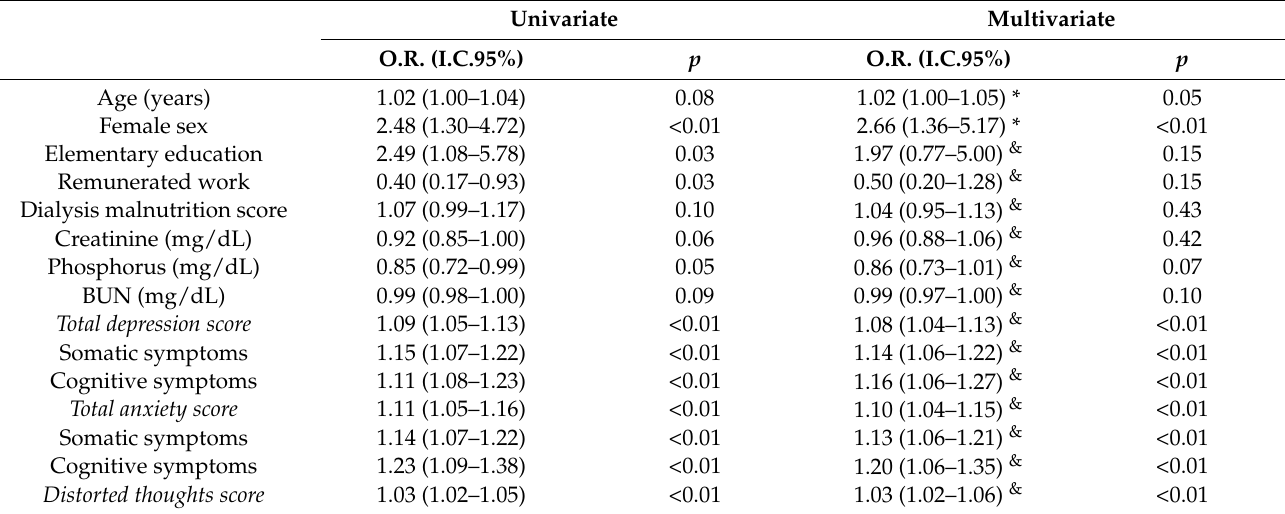
Table 5. Logistic regression analysis of factors related to diminished appetite (total score ≤ 25 points) in 182 ESRD patients treated with HD.